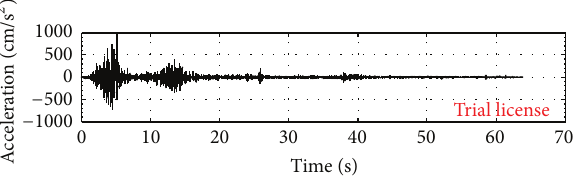
Figure 6: Scaled acceleration time history on duration and ampli- tude.